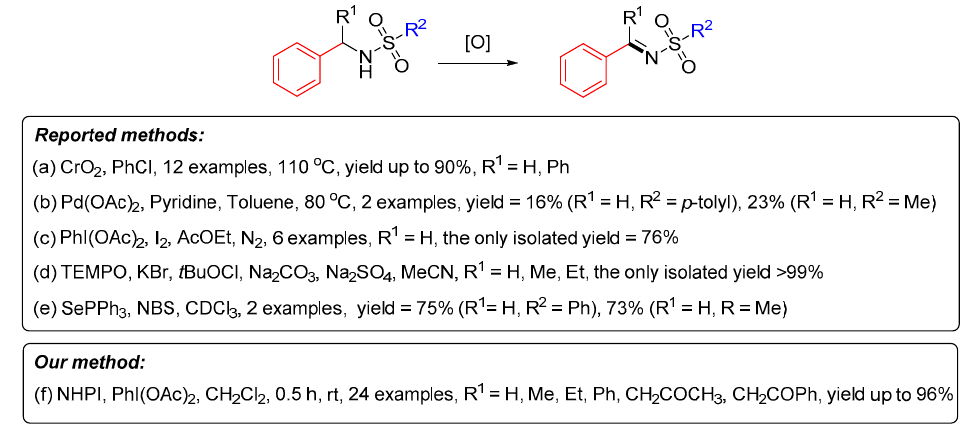
Figure 2. Oxidation conditions from sulfonamides to N -sulfonylimines.